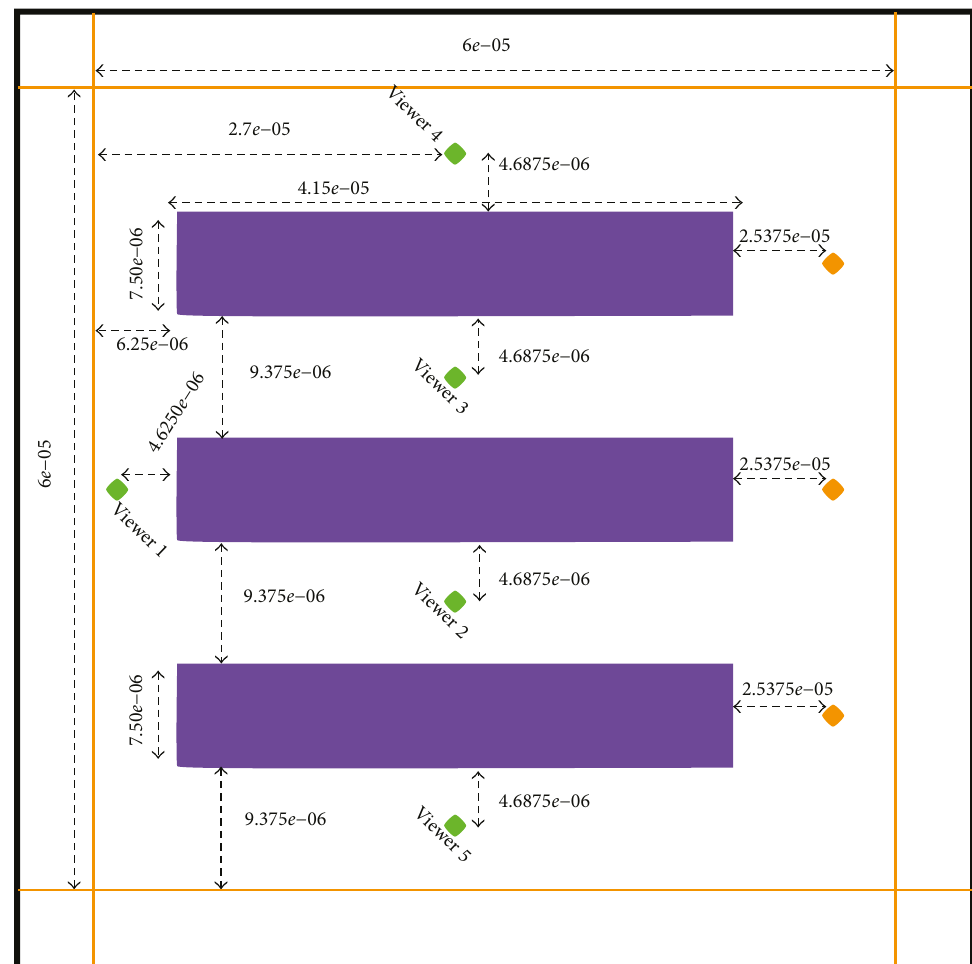
Figure 13: Con fi guration of the geometry of the coplanar